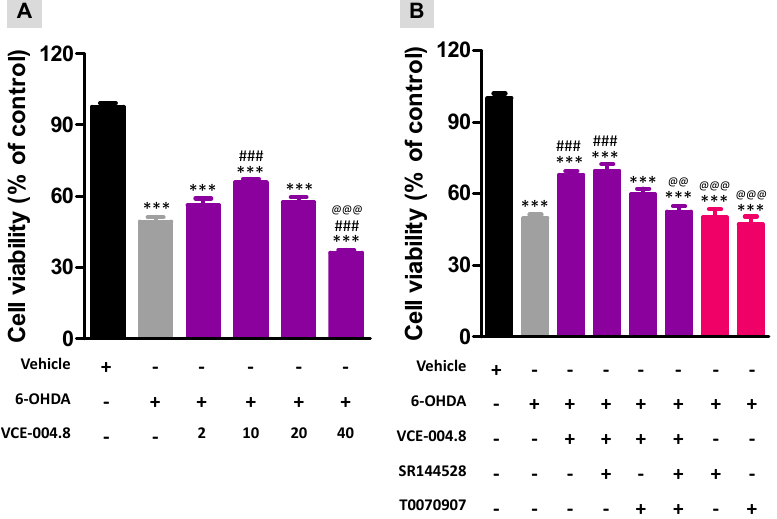
Figure 6. Cell viability measured with the MTT assay in cultured SH-SY5Y cells at 24 h to be treated with: ( A ): different concentrations of VCE-004.8 (2, 10, 20, and 40 µM) against 6-OHDA (200 µM), and ( B ): VCE-004.8 (10 µM) against 6-OHDA (200 µM), in the absence or the presence of T0070907 (10 µM), SR144528 (10 µM), or both. In all cases, a group with cells exposed to vehicles was also included to determine the 100% of cell viability. Values are means ± SEM of at least 4 independent experiments each performed in triplicate. Data were assessed by the one-way analysis of variance followed by the Bonferroni test (Both panels: *** p < 0.005 versus control cells; ### p < 0.005 versus cells exposed to 6-OHDA+vehicle; Panel A: @@@ p < 0.005 versus cells treated with the other VCE-004.8 concentrations; Panel B: @@ p < 0.01, @@@ p < 0.005 versus cells treated with VCE-004.8 in absence or presence or SR144528).